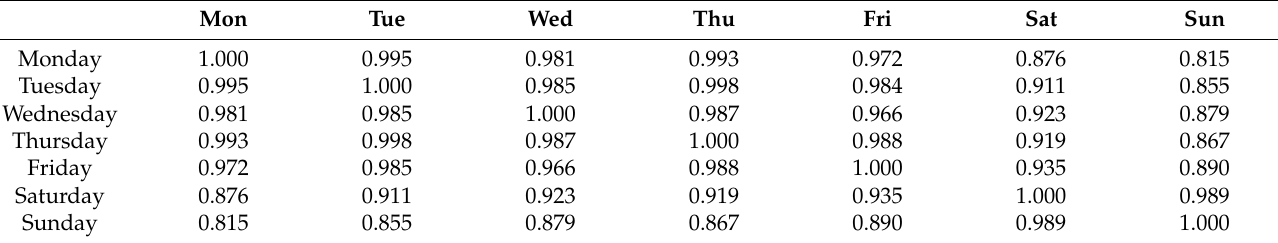
Table 9. Similarity matrix of carbon emissions of Sanya’s